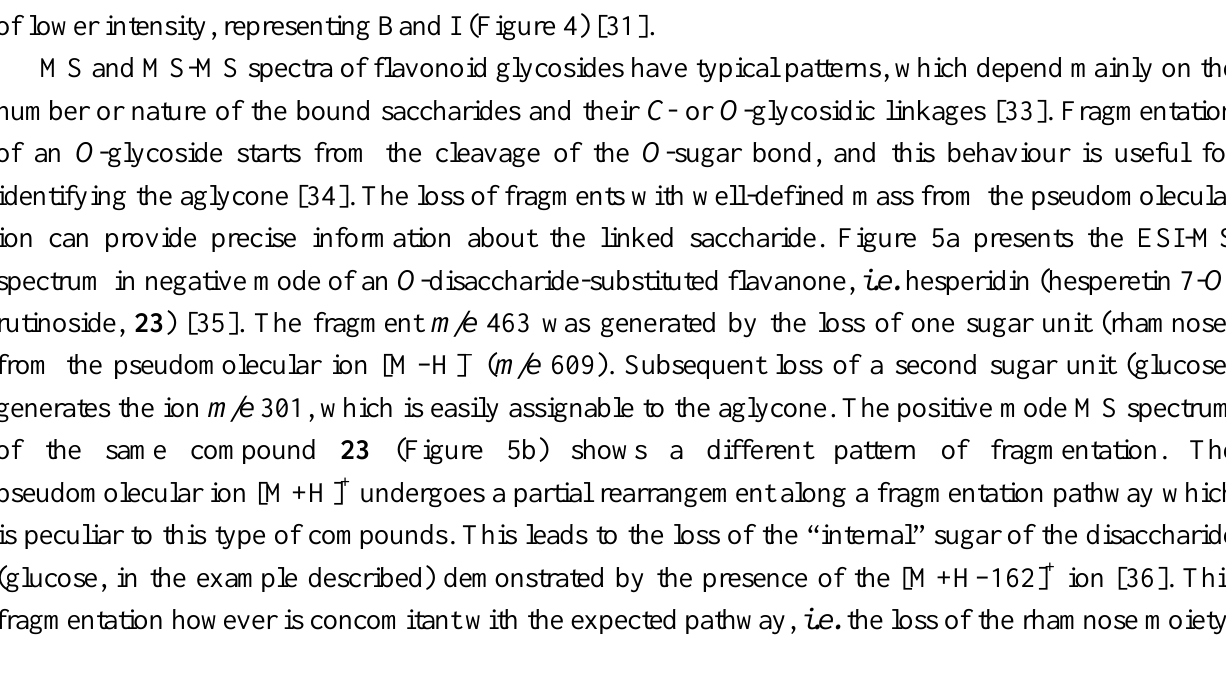
Figure 5. Negative mode (a) and positive mode (b) ESI-MS spectra of a flavanone bearing a disaccharide as a substituent (hesperidin, 23